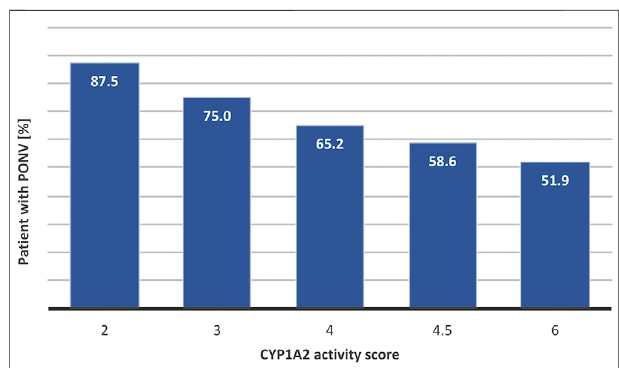
FIGURE 5 | Correlation between CYP1A2 activity and levels of PONV. Predicted CYP1A2 activity scores have been calculated based on genotypic data taking into account activation due to smoking by multiplying the genotypically predicted activity score by 1.5 × in presence of smoking (Lesche et al., 2020). The fi gures showy the proportion of patients experiencing PONV in each CYP1A2 activity category. The R 2 of the linear regression between score activity and PONV risk reaches